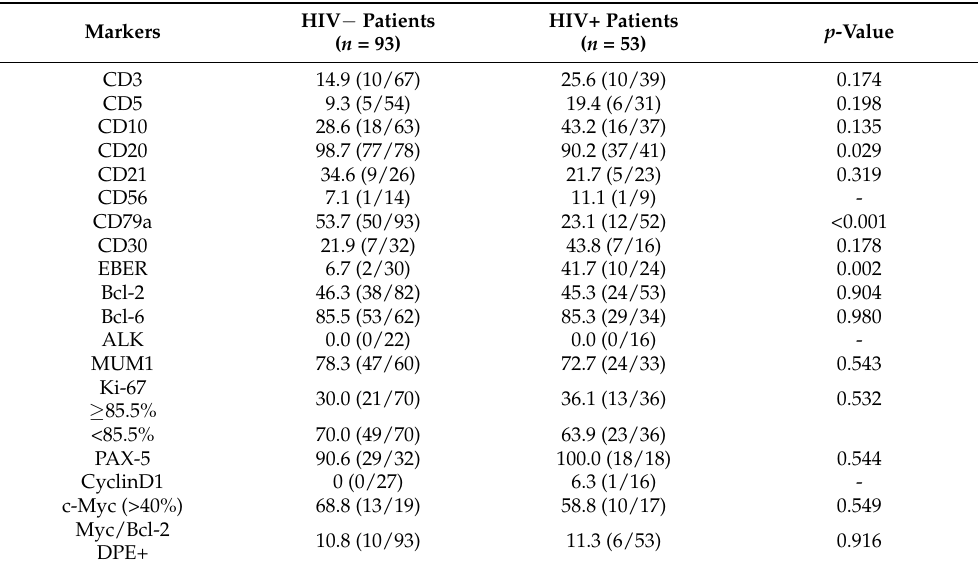
Table 2. Comparison of phenotypic markers in DLBCL patients with and without HIV infection.